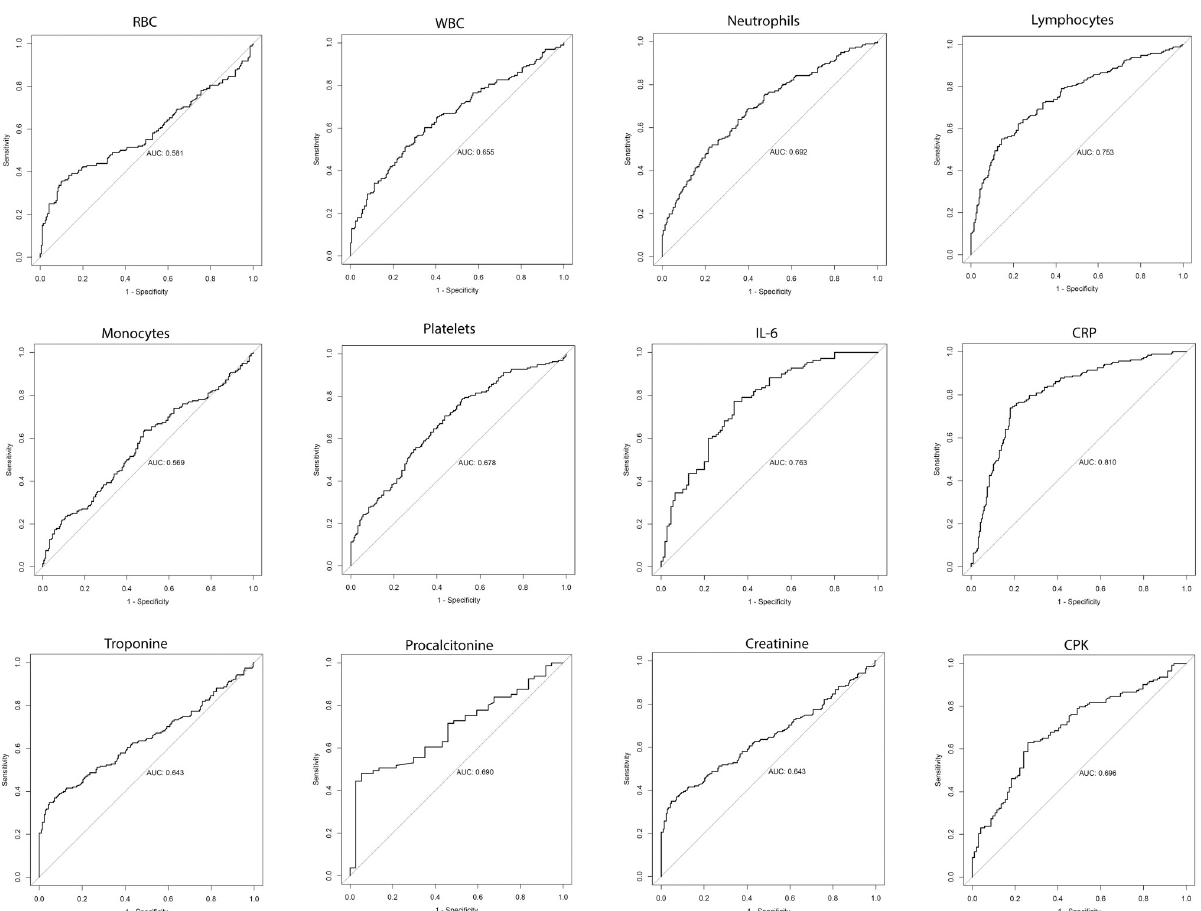
Fig 1. Comparison of the means of values of different laboratory tests at T1 and T2 between survivors and non-survivors.